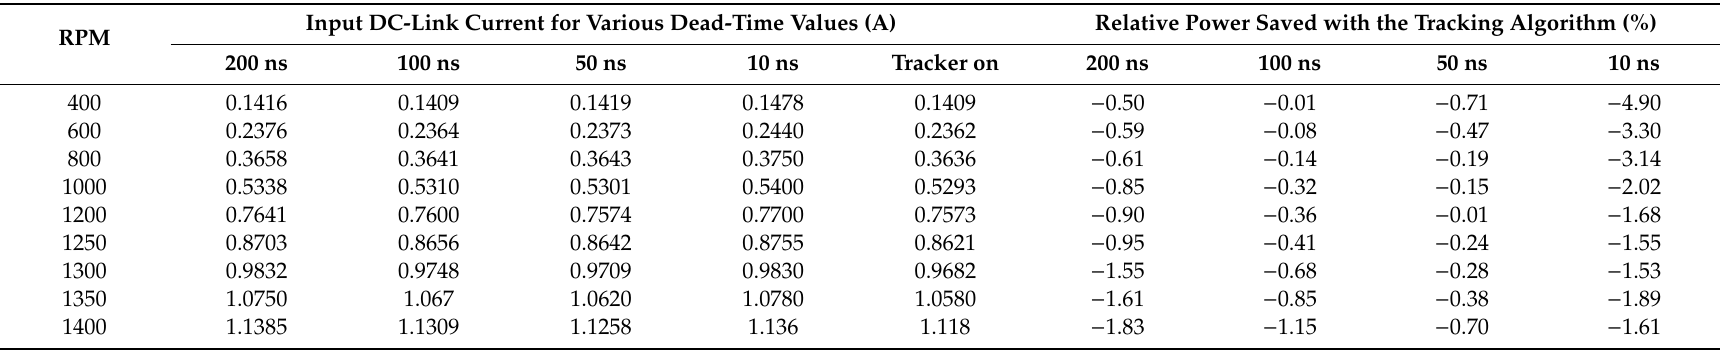
Table 3. Relative comparison of VSI losses for selected values of fixed dead-time compared to optimized dead-time for various speed references and R load = 73 Ω .